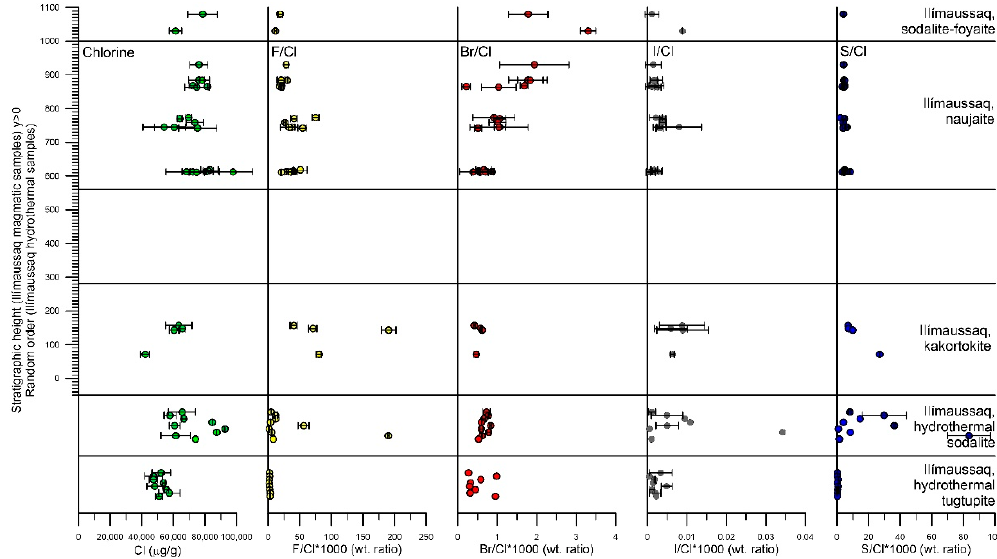
Figure 6. X / Cl and Cl systematics in sodalite and tugtupite. Cl concentration data are the same as in Figure 4 and are added for easy comparison between the Cl contents and the X / Cl ratios in the sodalite samples. Although tugtupite data are not discussed in the text (other than in the results section) they are incorporated for completeness and easy comparison to the concentration data in Figure 4. Magmatic Il í maussaq samples are sorted according to their stratigraphic height in the intrusion, other samples are randomly ordered within each group.